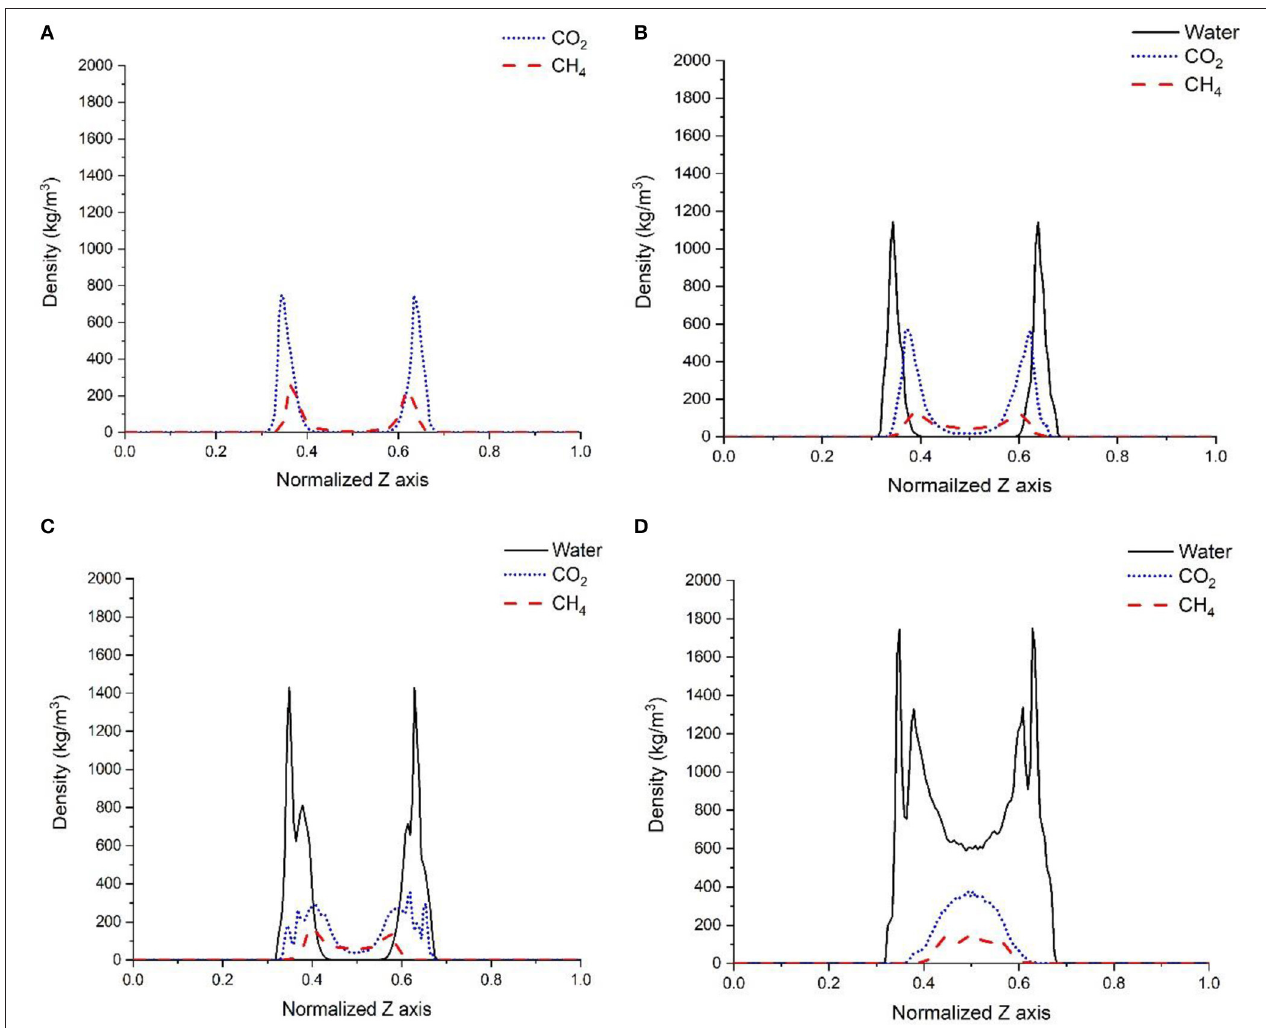
FIGURE 3 | Density profiles of CO 2 , and CH 4 in the absence of pore water (A) , one layer of confined water composed of 150 water molecules (B) , 500 water molecules (C) , and 1,296 water molecules that correspond to a density of bulk water of 1 g/cm 3 (D) . The X-axis represents the normalized pore surface in the